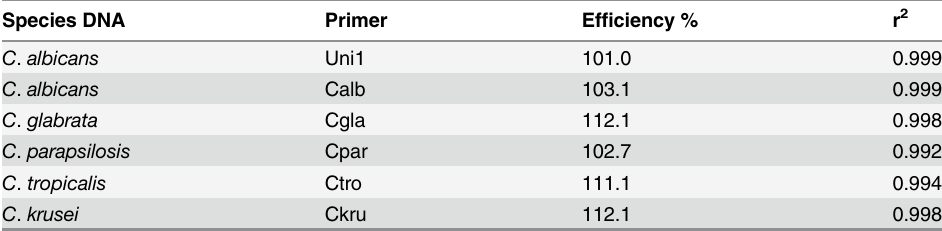
Table 3. qPCR primer sensitivities and reaction ef fi